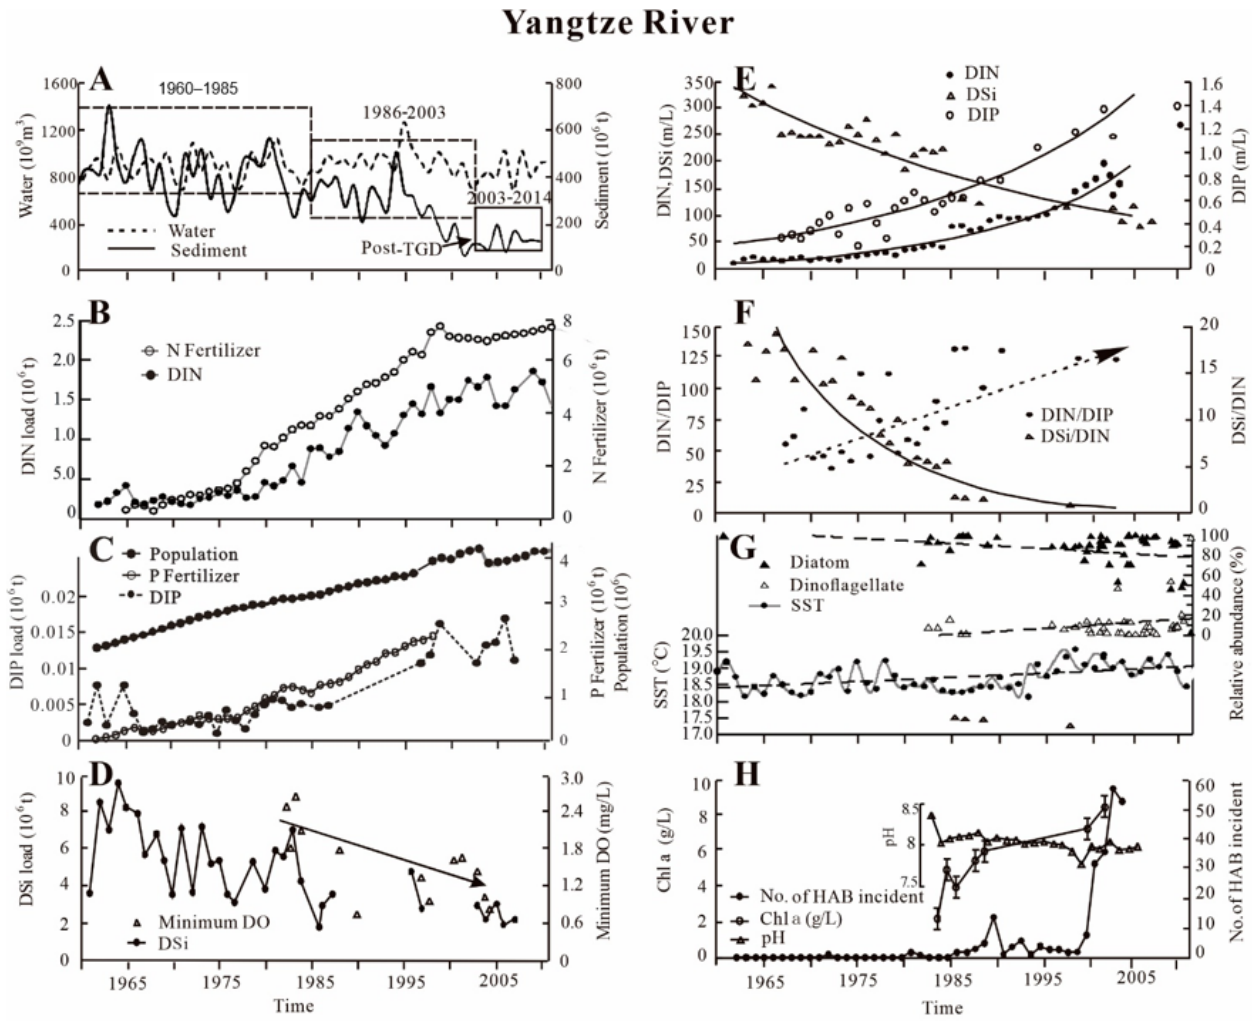
Figure 2. Long-term variations of both riverine materials transport to the Yangtze delta-estuary and estuarine ecological components. ( A ) Sediment and freshwater (recorded at Datong hydro-gauging station, Figure 1A; CWRCMWR, 1960–2016); ( B – F ) Nutrients (CWRCMWR, 1960–2016). Fertilizer and population in ( B , C ) sourced from http://www.stats.gov.cn/tjsj/ ndsj/ (accessed on 2 March 2021) [4]; ( G ) Diatom and relative dinoflagellate abundance of the Yangtze estuary [7]; ( H ) Chla [8]; HAB (http://www.mnr.gov.cn/sj/sjfw/hy/gbgg/zghyhjzlgb/ (accessed on 2 March 2021) [9] and Tang (2009)